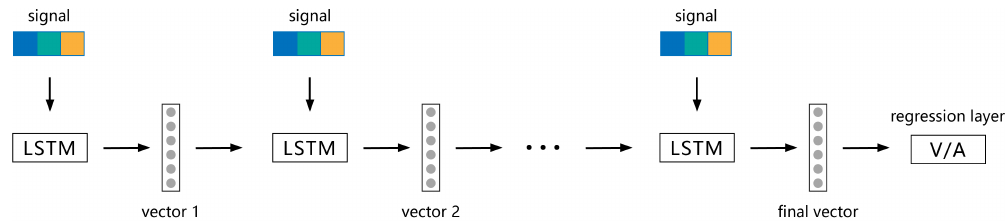
Figure 5. The LSTM model. The signal is fed into each LSTM module point by point, and each point contains three channels (phasic, tonic, and